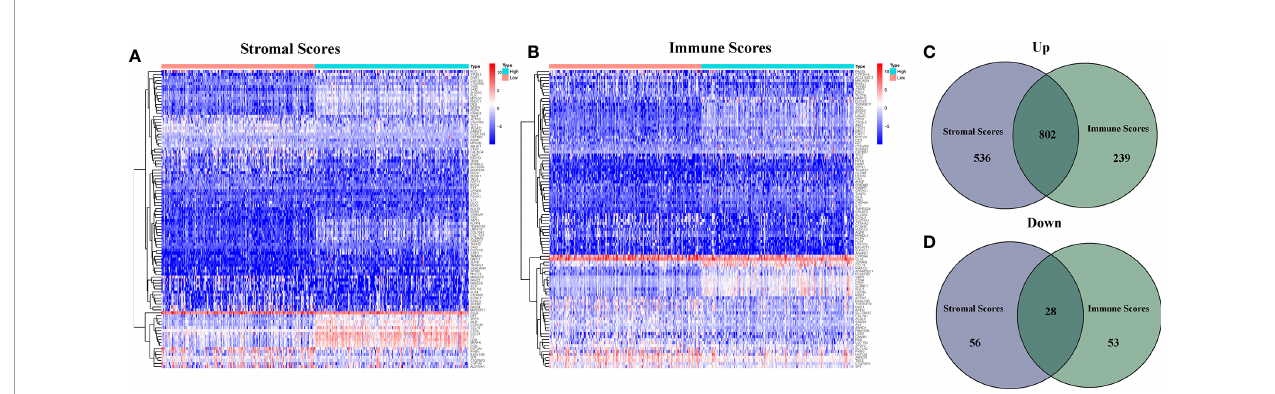
FIGURE 2 | Heatmaps and Venn plots for DEGs. (A) Heatmap for DEGs generated by comparison of the high score group vs the low score group in Stromal Score; (B) Heatmap for DEGs generated by comparison of the high score group vs the low score group in Immune Score; (C, D) Venn plots showing common up- regulated and down-regulated DEGs shared by Immune Score and Stromal